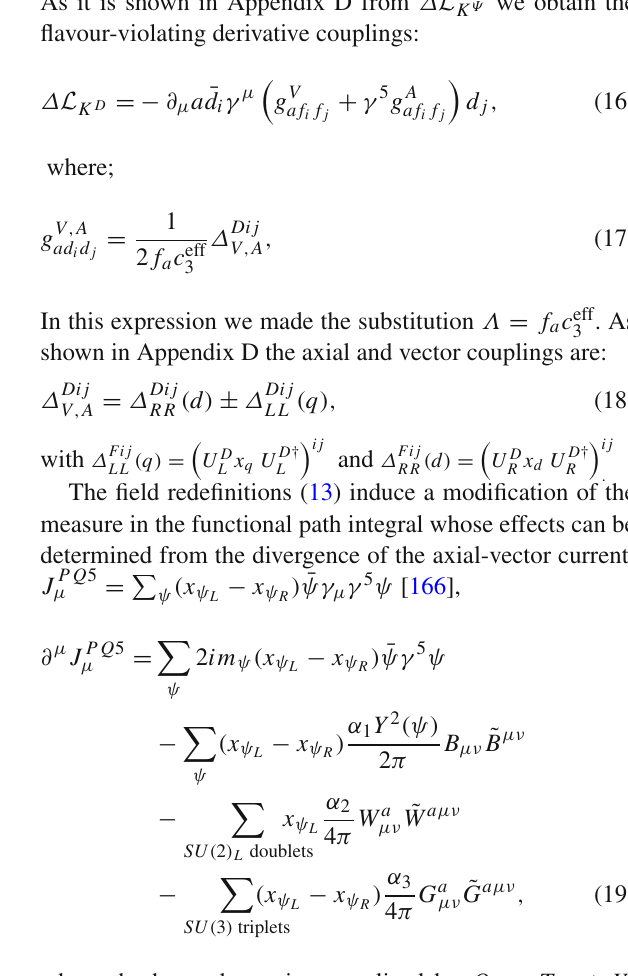
Table 3 The three columns in each slot are the Peccei-Quinn charges x ψ the right-handed up-type x u